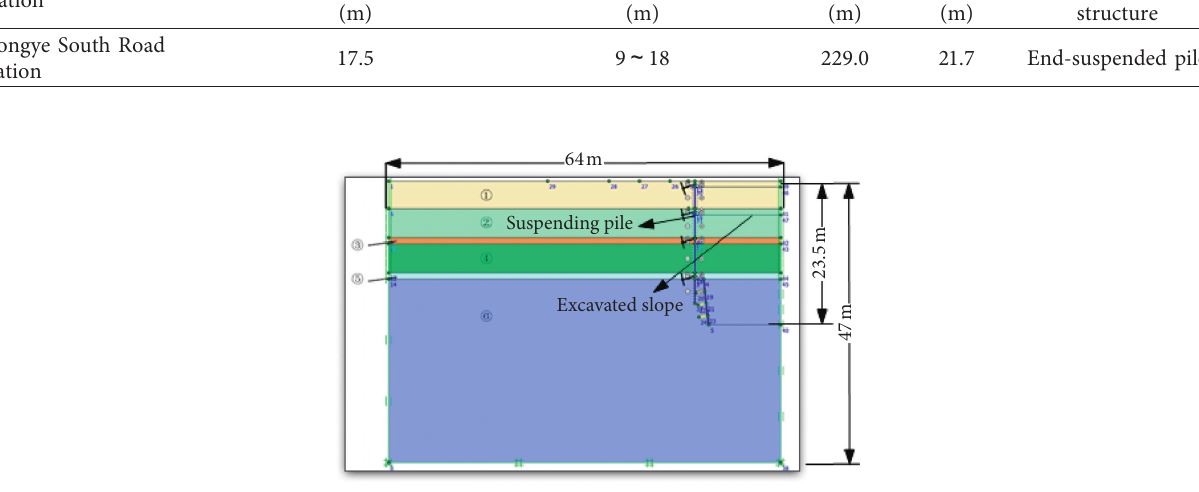
Figure 1: Finite element model of foundation pit supported by suspended foot piles. Table 2: Physical and mechanical parameters of rock and soil.